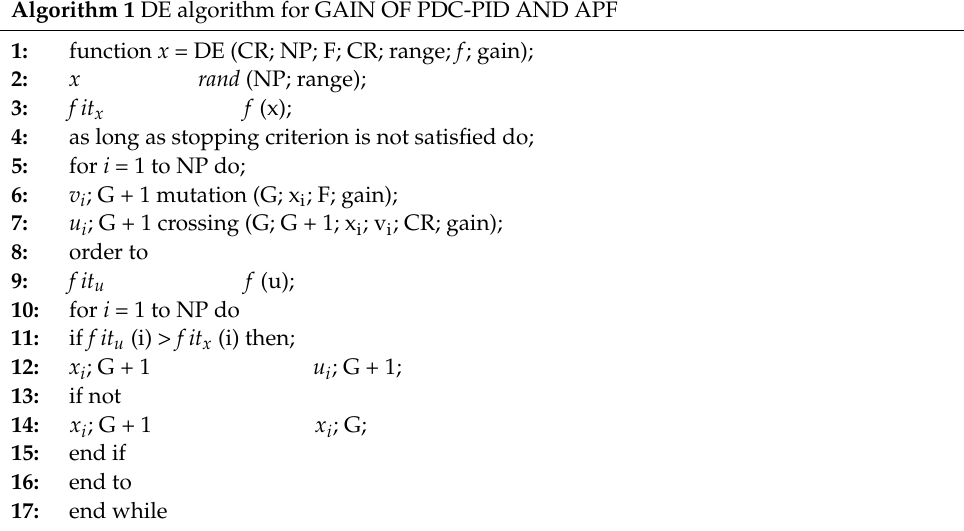
Algorithm 1 DE algorithm for GAIN OF PDC-PID AND APF